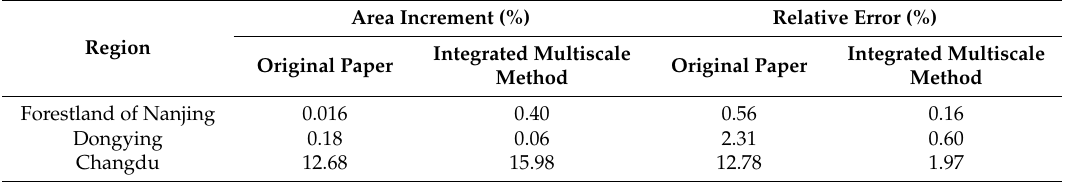
Table 4. Comparison of surface area calculation methods between this study and the literature.